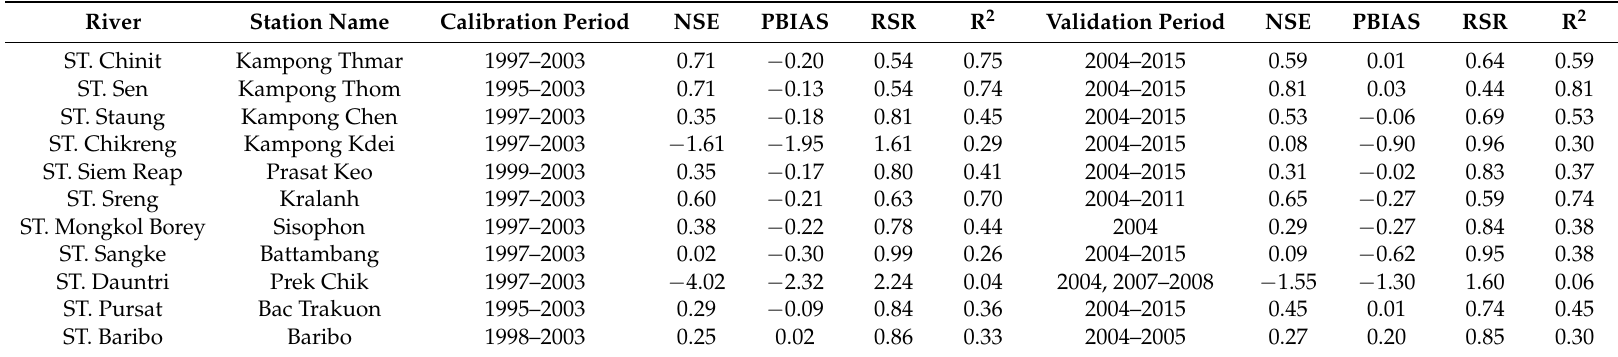
Table 3. Calibration and validation performance for daily time-step simulations at all 11 rivers in Tonle Sap Lake Basin showing the Nash-Sutcliffe efficiency (NSE),